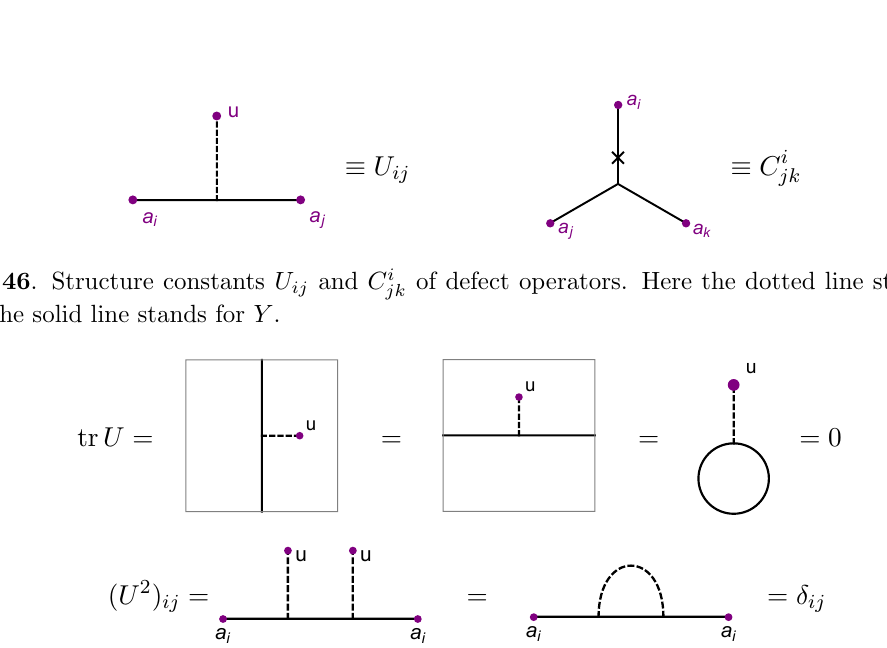
Figure 47 . Some constraints on U ij . In the (cid:12)rst line, going from the torus one-point function of u attached to a Y loop to the u -tadpole graph on the plane, we made use of the assumption that the TQFT has a unique vacuum, i.e., the only bulk local operator is the identity. In the second line, we used the triviality of the crossing kernels with X external